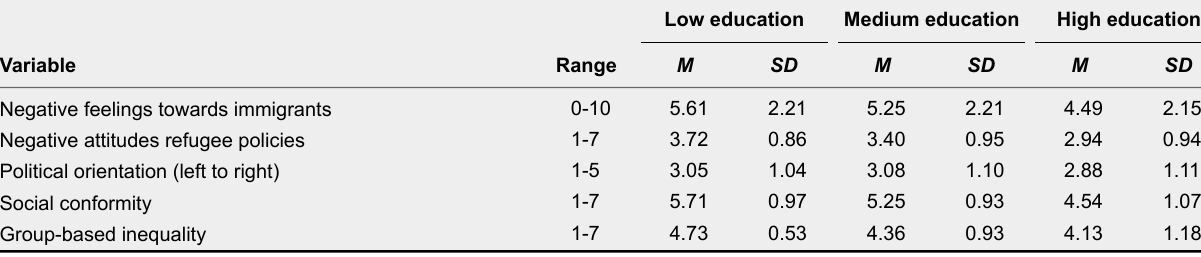
Means, Standard Deviation, and Range for the Main Measures per Education